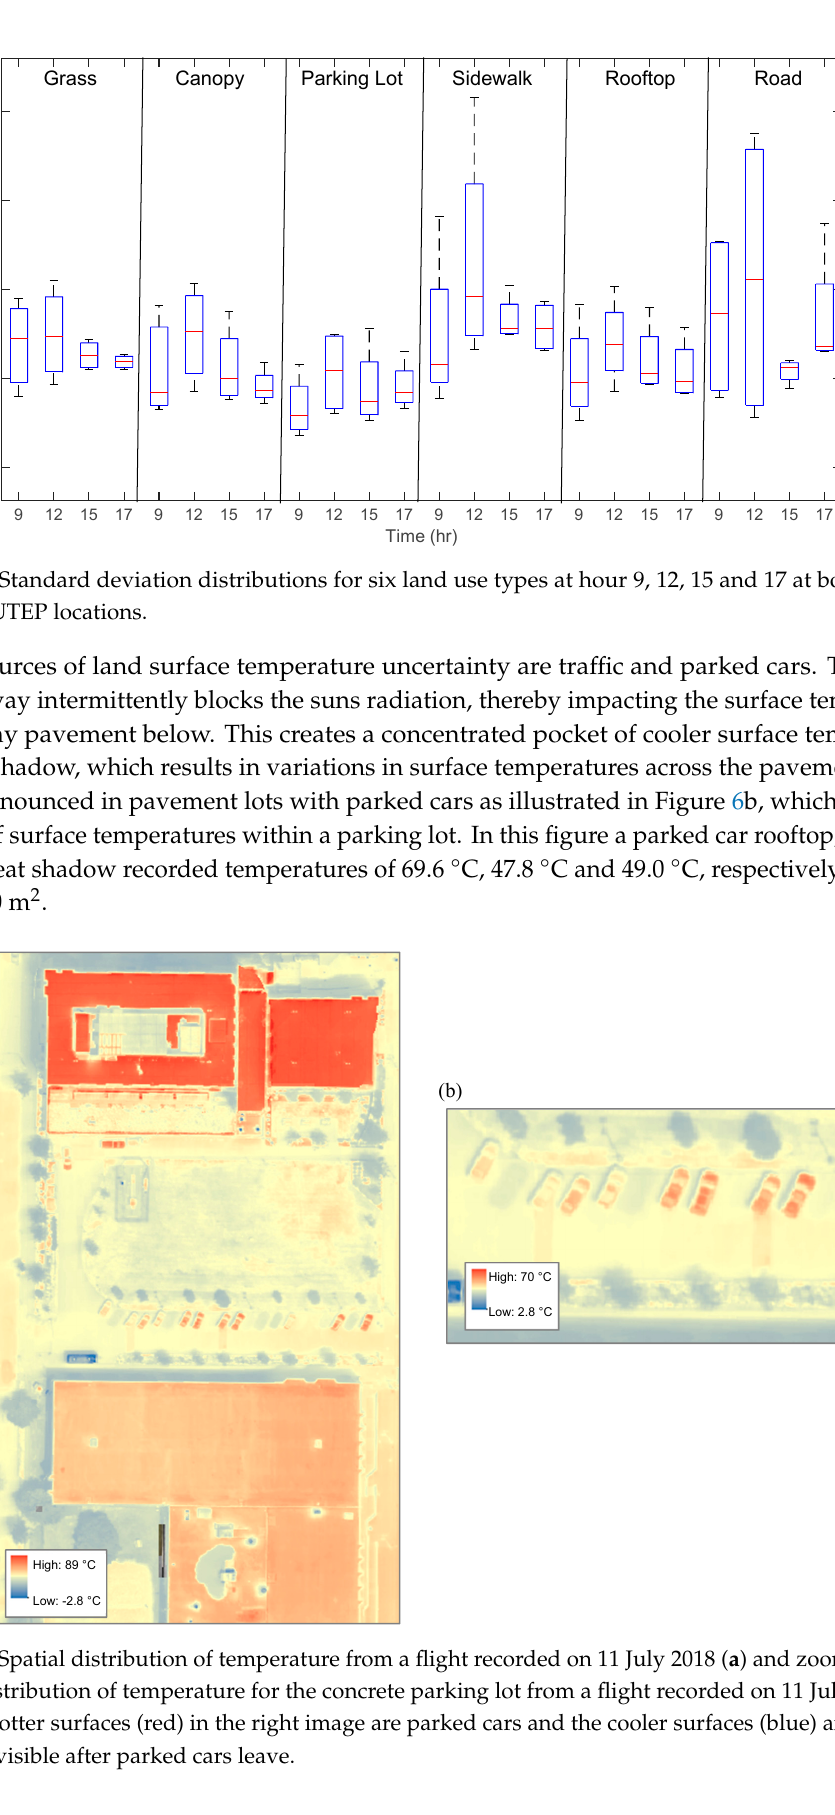
10 of 19 Figure 4 . Boxplot distribution of average temperature, standard deviation and coefficient of variation from 14 recorded flights in Milwaukee, WI. We evaluated the variation in surface temperatures throughout the day and found that the highest degree of variation occurred at noon. This is demonstrated in the Figure 5, which shows box